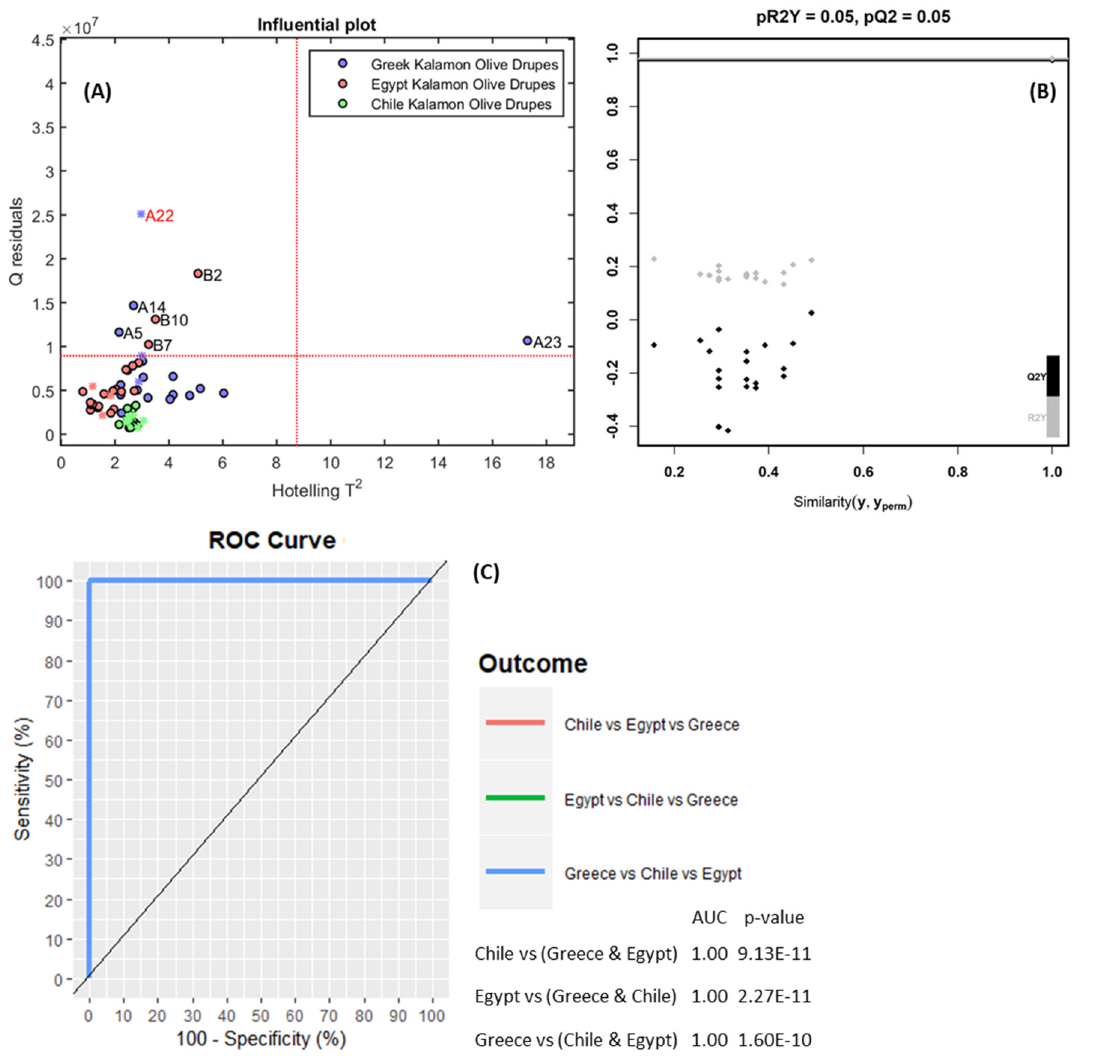
Figure 2. ( A ) Influential analysis by Hotelling’s T 2 distribution; ( B ) Permutation test of cumulative R 2 Y and Q 2 values; ( C ) Receiver Operating Characteristics (ROC) curve for the developed PLS-DA.